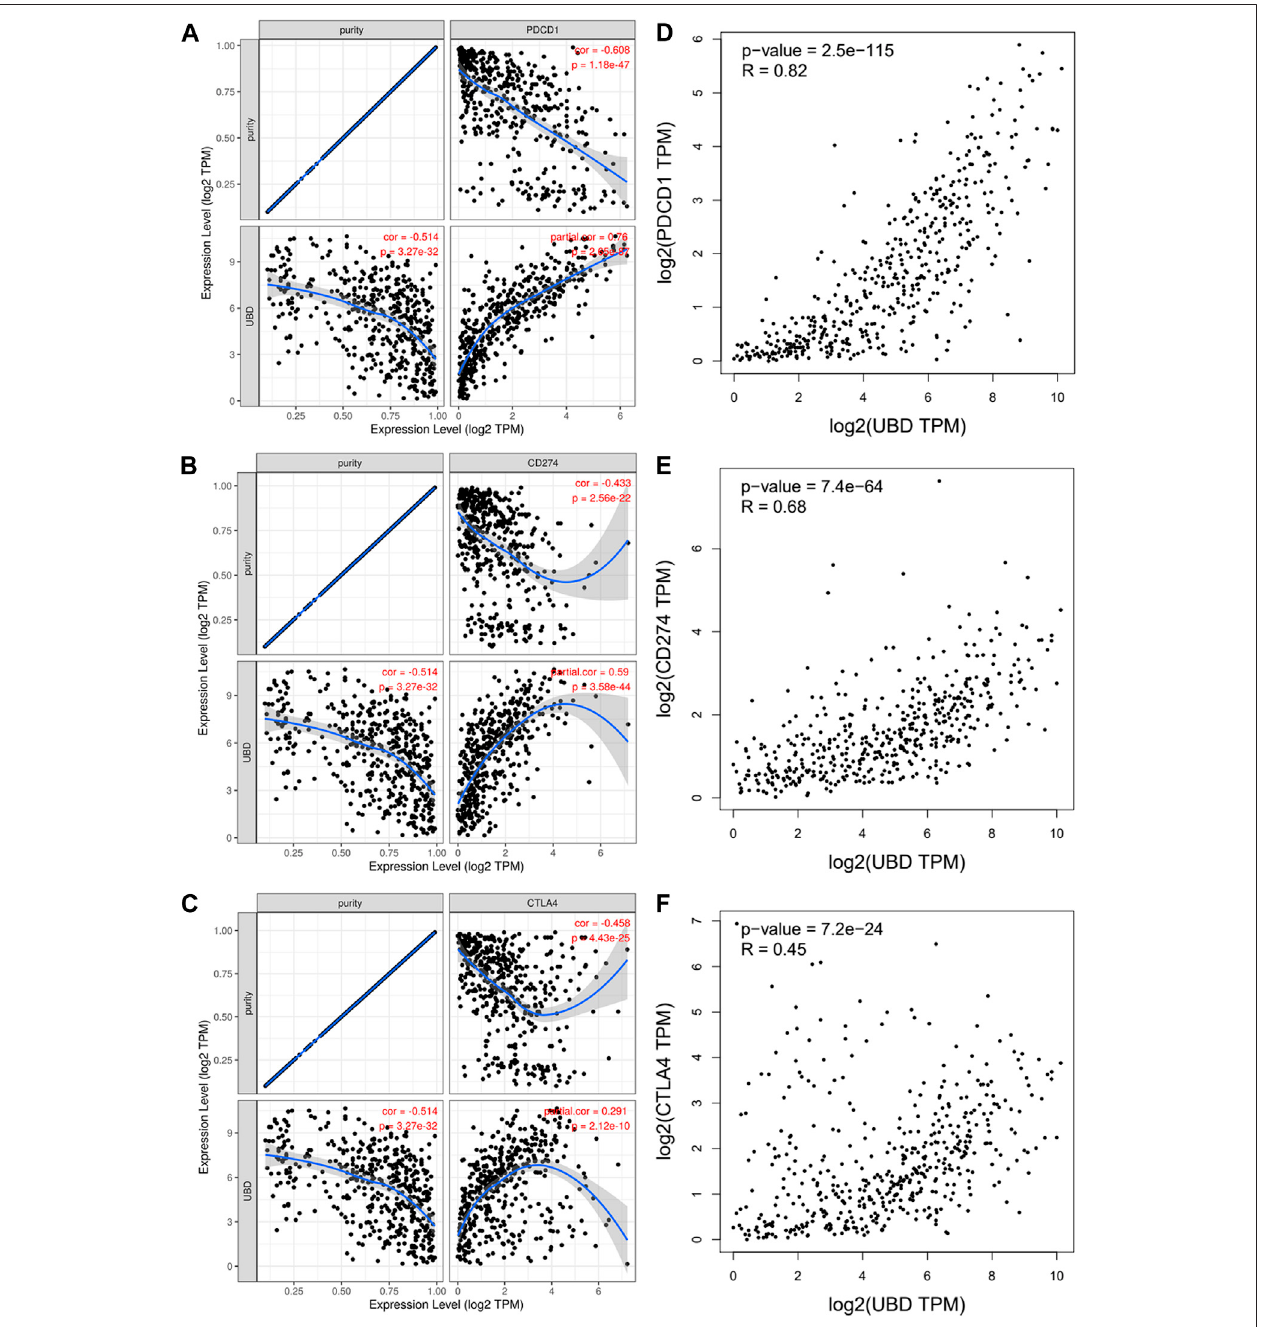
FIGURE 7 | The correlation between FAT10 expression and PD-1, PD-L1 and CTLA-4 expression in SKCM. (A) Use TIMER to adjust the spearman correlation between FAT10 and PD-1 expression in SKCM through purity. (B) Use TIMER to adjust the spearman correlation between FAT10 and PDL1 expression in SKCM through purity. (C) Use TIMER to adjust the spearman correlation between FAT10 and CTLA-4 expression in SKCM through purity. (D) The expression correlation of FAT10 and PD1 in SKCM via GEPIA analysis. (E) The expression correlation of FAT10 and PD-L1 in SKCM via GEPIA analysis. (F) The expression correlation of FAT10 and CTLA-4 in SKCM via GEPIA